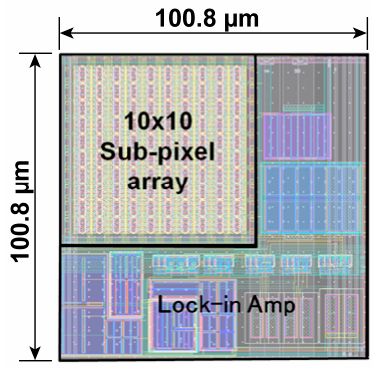
Figure 12. SRS pixel layout showing the sub-pixel array and lock-in amplifier.